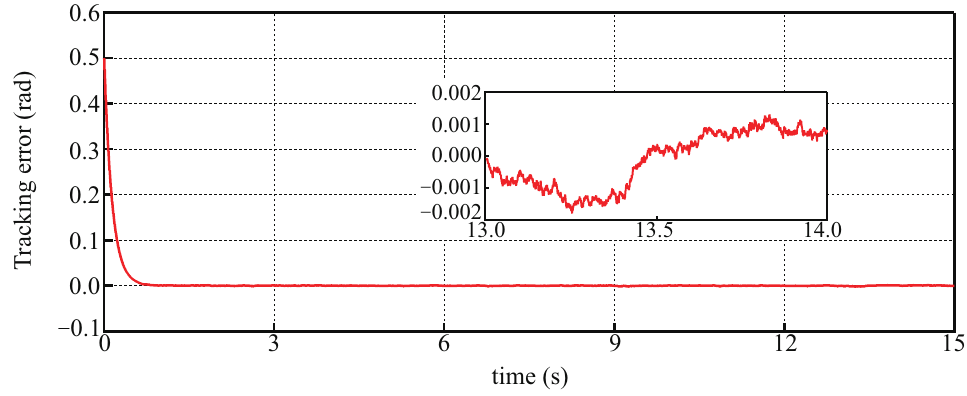
Figure 5. Tracking error e 1 under the proposed approach with